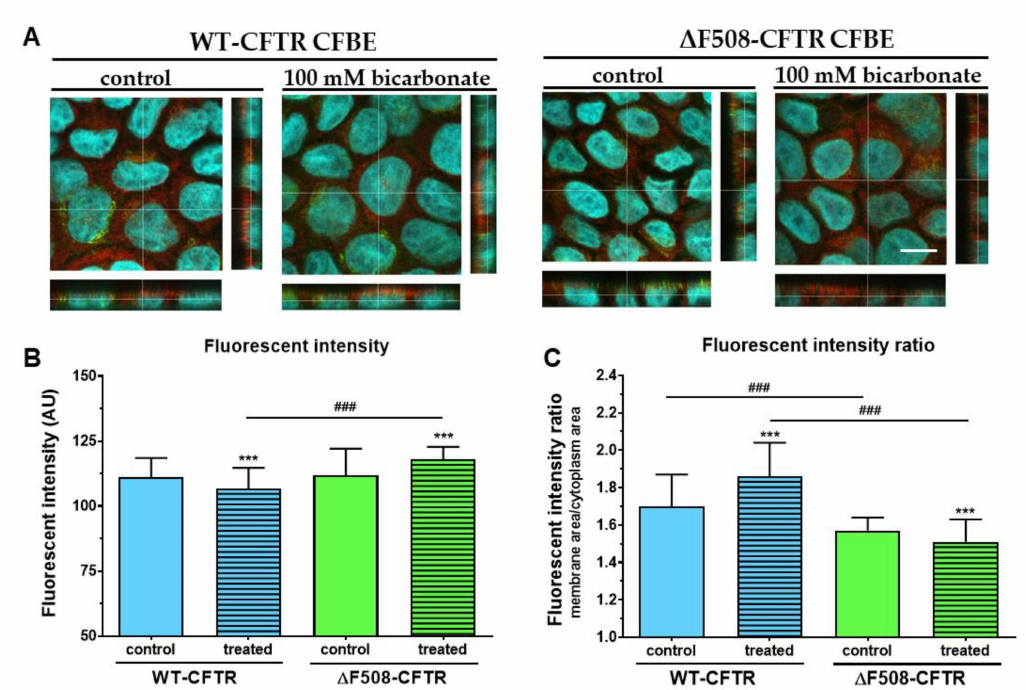
Figure 13. The e ff ect of sodium bicarbonate on the immunolocalization of CFTR channels in CFBE cells. ( A ) WT-CFTR and ∆ F508-CFTR CFBE cells were treated with culture medium containing 26 mM (control group) or 100 mM sodium bicarbonate for 24 h. Red color: immunostaining for CFTR. Green color: WGA lectin staining. Cyan color: cell nuclei. Bar: 10 µ m. Image analysis of the immunostainings showing ( B ) mean pixel intensities of the CFTR staining in the membrane region of the treatment groups and ( C ) the ratio of mean pixel intensities of the CFTR staining in the membrane region divided by mean pixel intensities of the CFTR staining in the cytoplasm regions. Values are presented as means ± SD, n = 4018 image stacks / group. Statistical analysis: 2-way ANOVA and Bonferroni test. ### p < 0.001 compared to the wild-type epithelial cells, *** p < 0.001 compared to the control